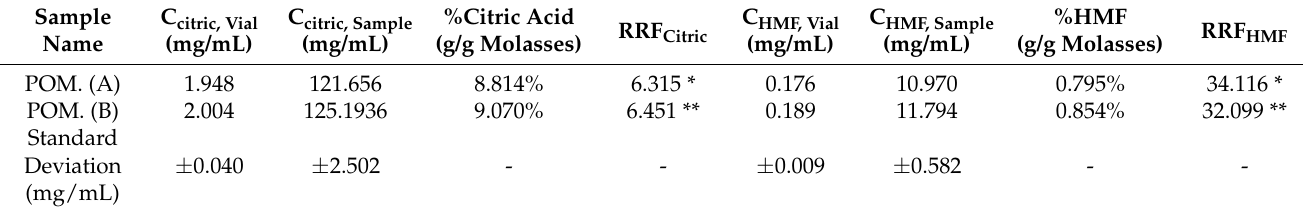
Table 2. Concentrations of species in vial: C i, vial (mg/mL), calculated concentration of species in commercial product: C i, sample (mg/mL), and RRF (relative response factor) of each species based on LA (levulinic acid) (ISD—internal standard): RRFi.